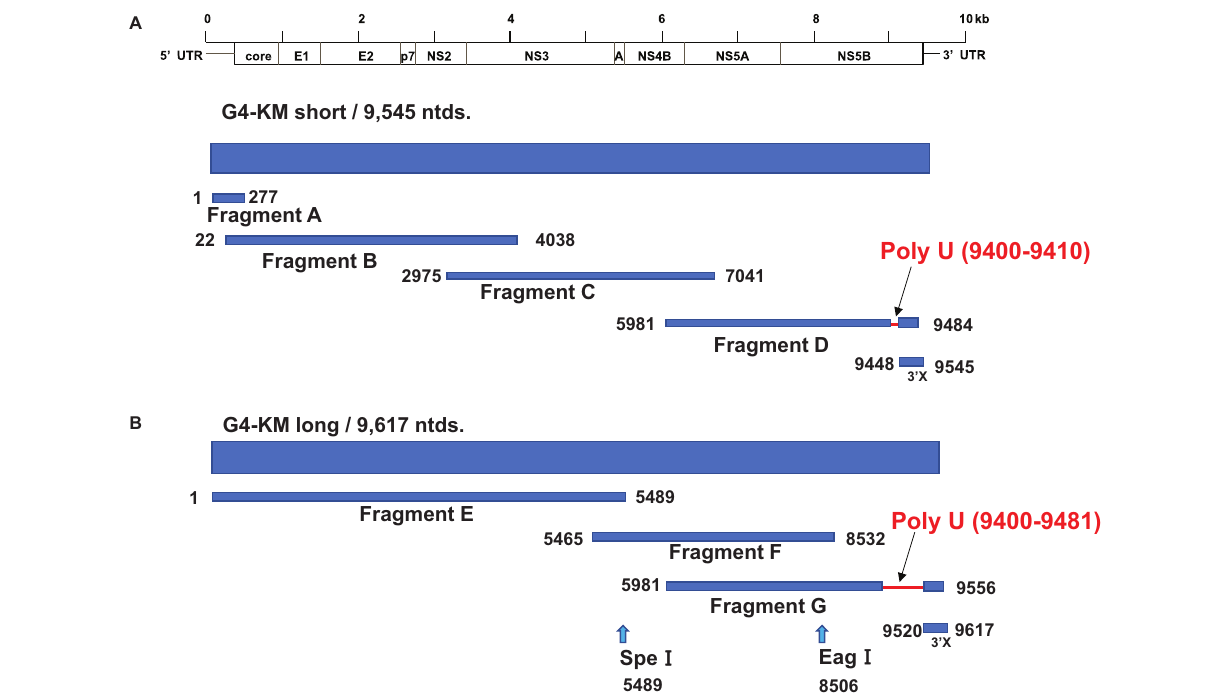
Frontiers in Microbiology |